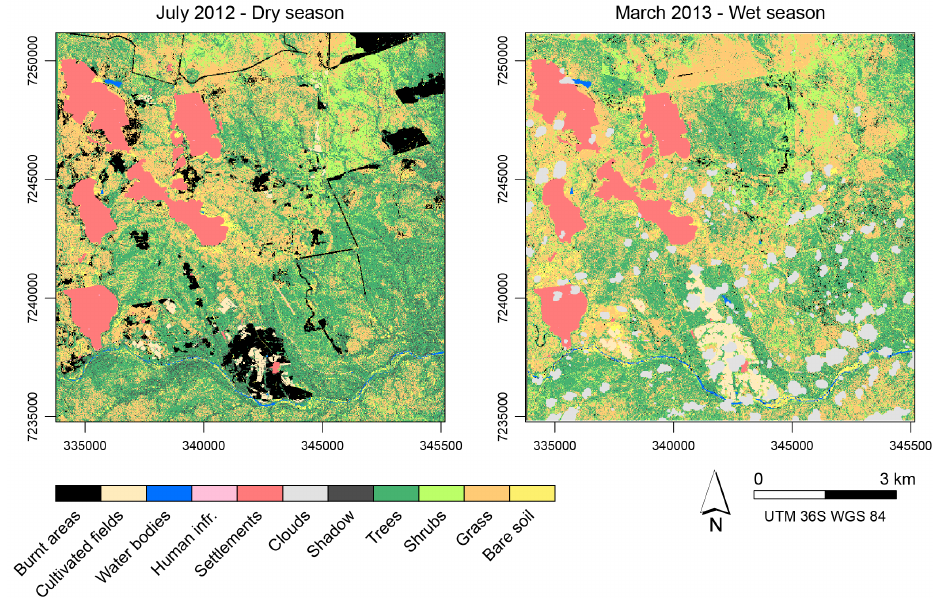
Figure 4. Land cover map for the July 2012 and March 2013 images, made using Object-Based Image Analysis (OBIA) and the random forests (RF) classifier.